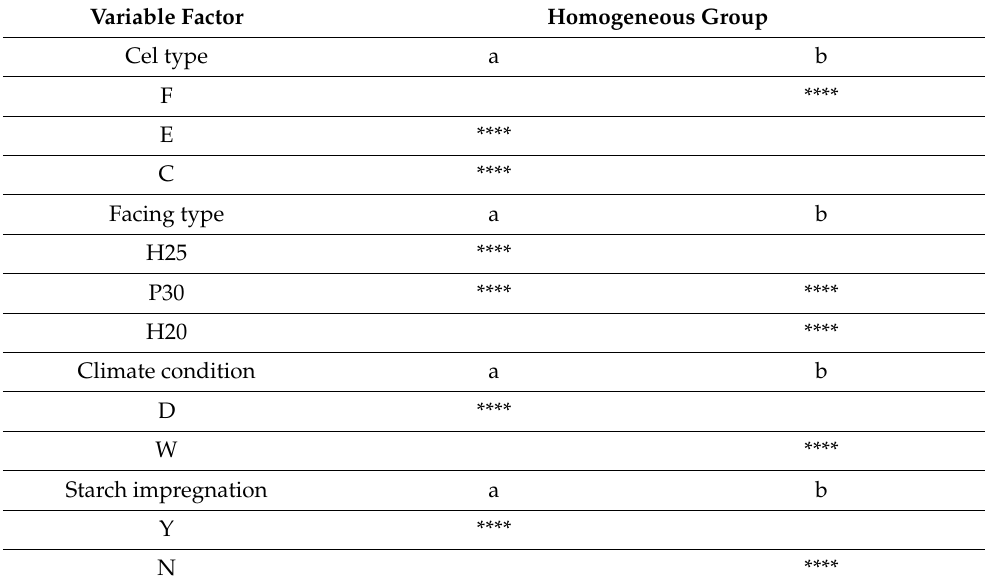
Table 7. Summary of statistically homogeneous groups determined on the basis of the HSD Tukey test for selected variable factors in the research for the direction of orthotropy X. (The symbol **** meaning that results are not statistically